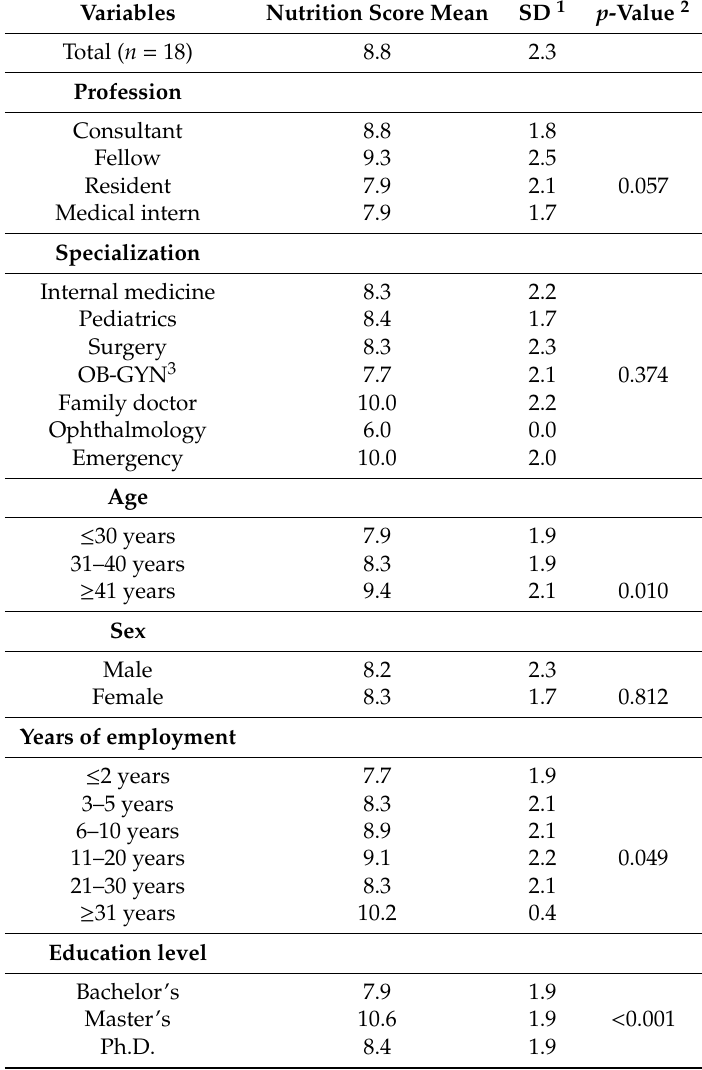
Table 3. Association between the total nutrition score and the main study